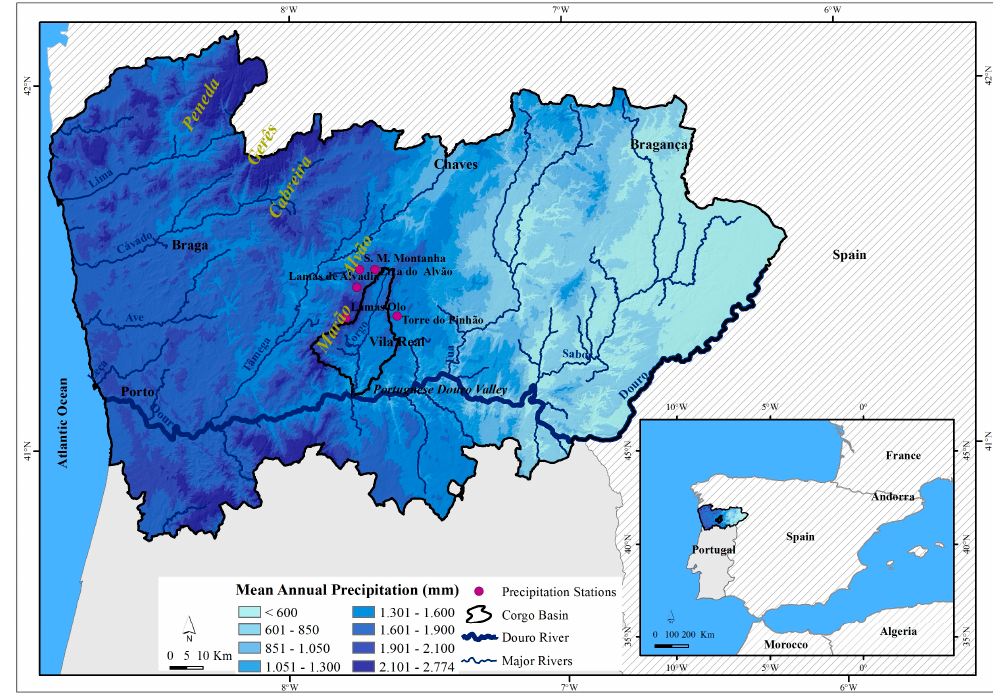
Figure 1. Location of Corgo basin in Northern Portugal and mean annual precipitation (1960–2000) in the study area.